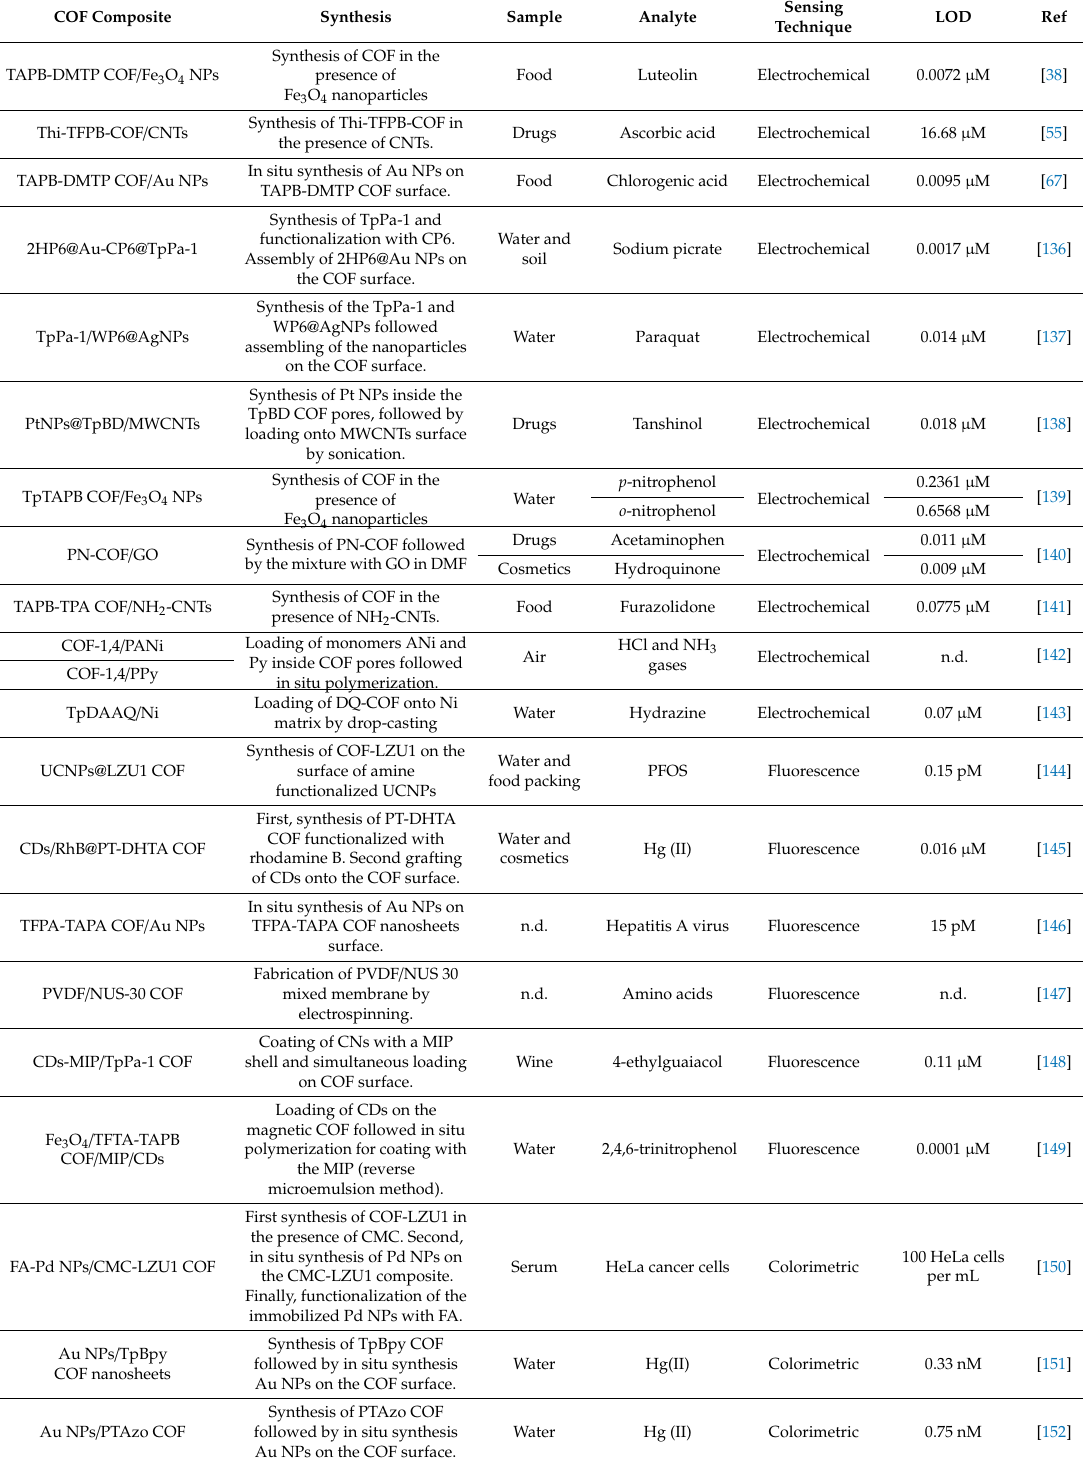
Table 4. Chemical sensing applications of COF